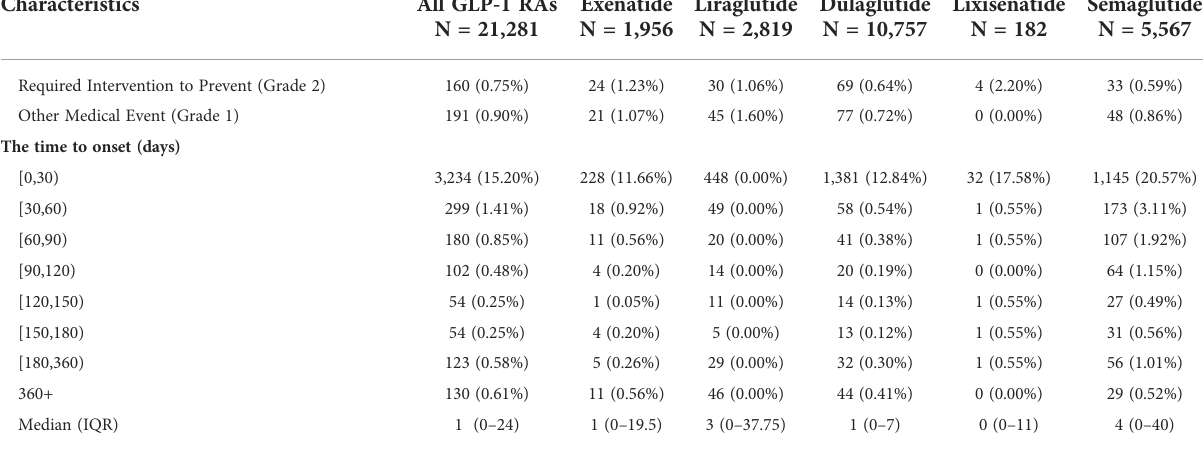
and mesenteric panniculitis).